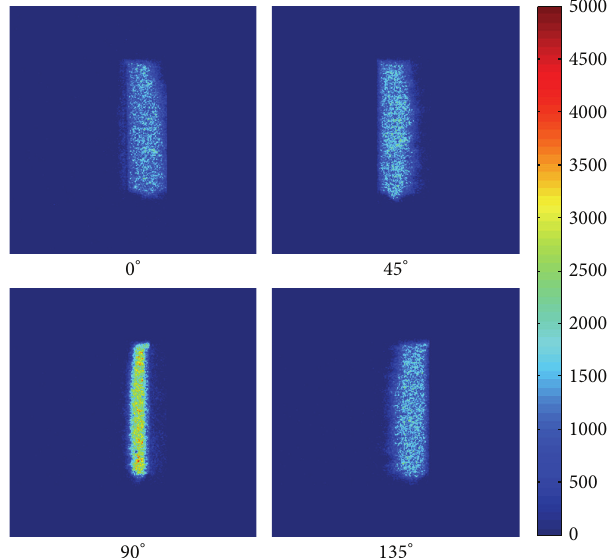
Figure 7: Projection images from four projection angles of 0, 45, 90, and 135